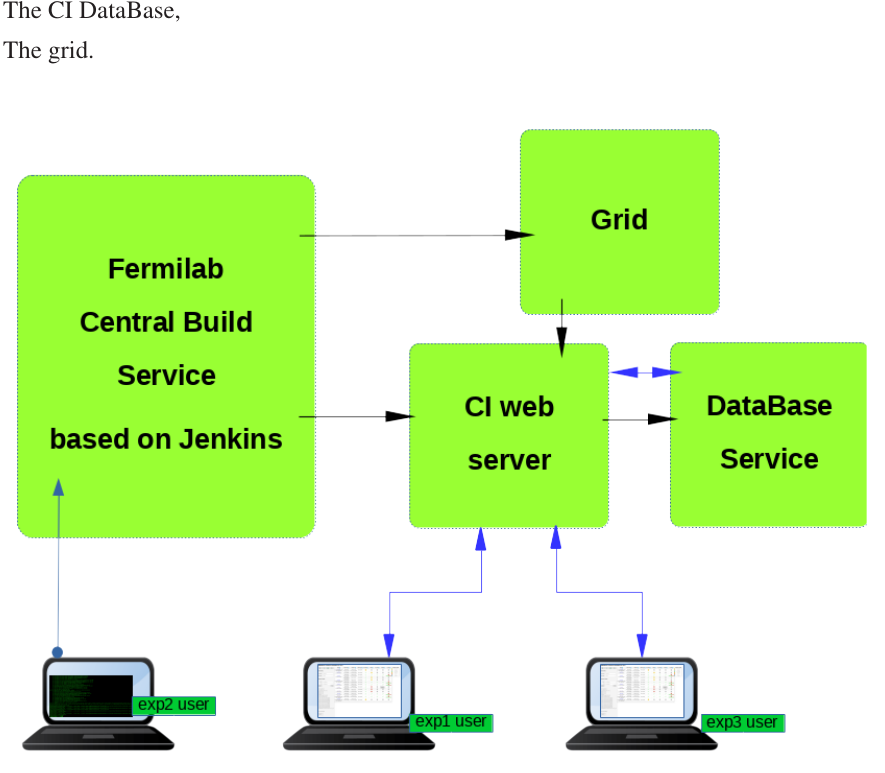
Figure 1. CI system architecture